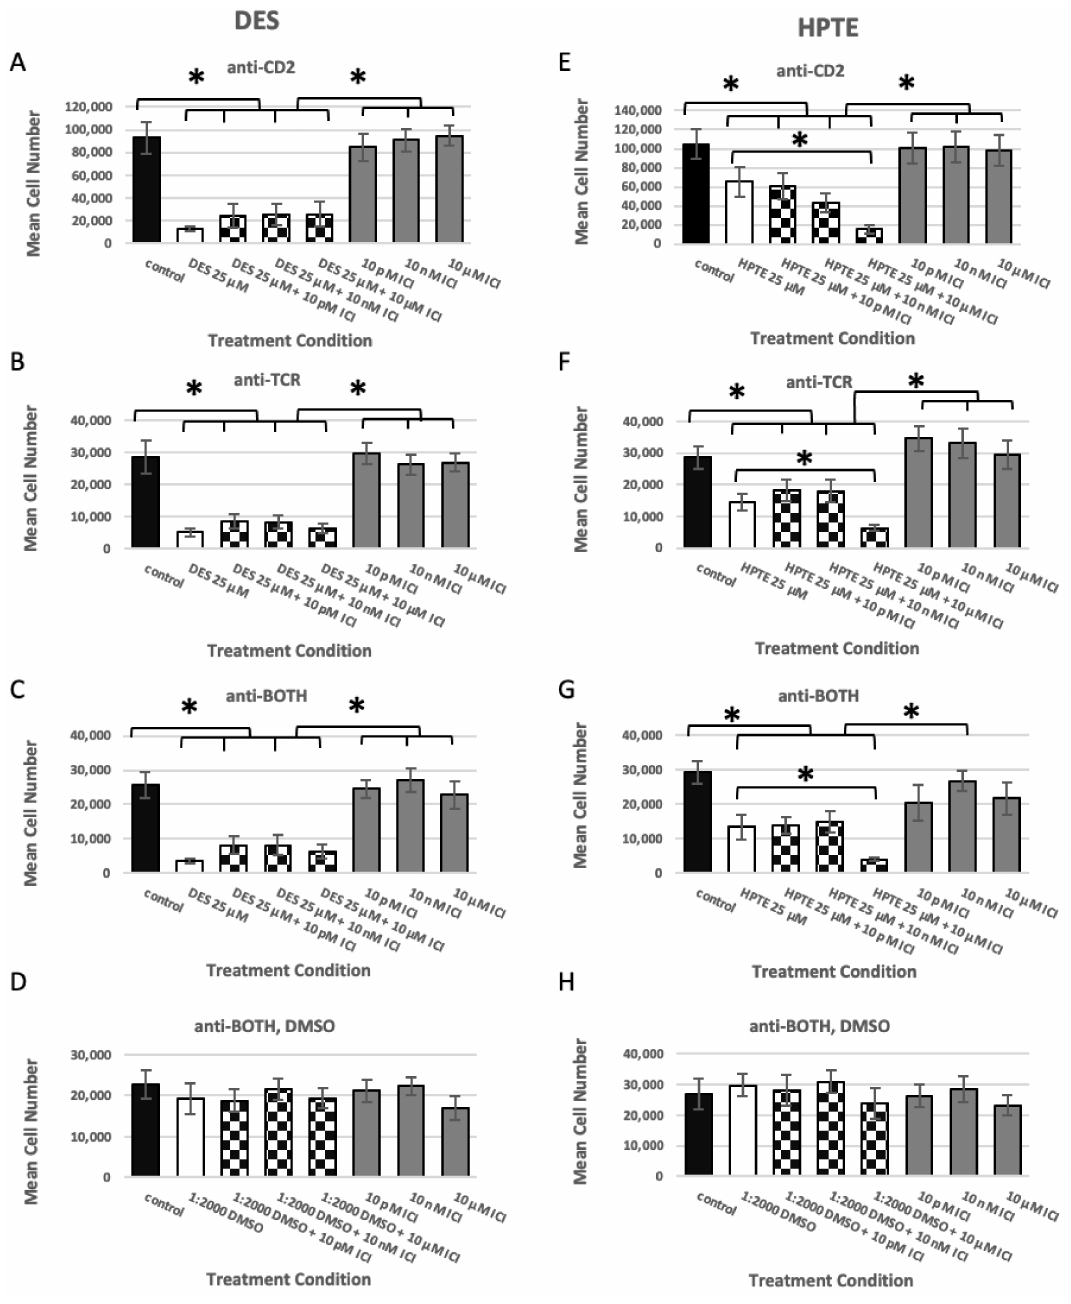
Figure 1. Estrogen receptor alpha inhibitor ICI 182,780 does not rescue DES-treated or HPTE-treated embryonic thymocytes from cell death. Embryonic thymocytes were treated with ICI prior to and during incubation in the differentiation culture. Pre-treated thymocytes were cultured 18–24 h in the presence of the antibody listed above each panel and 50 µ M DES ( A – D ) or HPTE ( E – H ). DES N = 9, HPTE N = 8, * Tukey HSD post-hoc p <